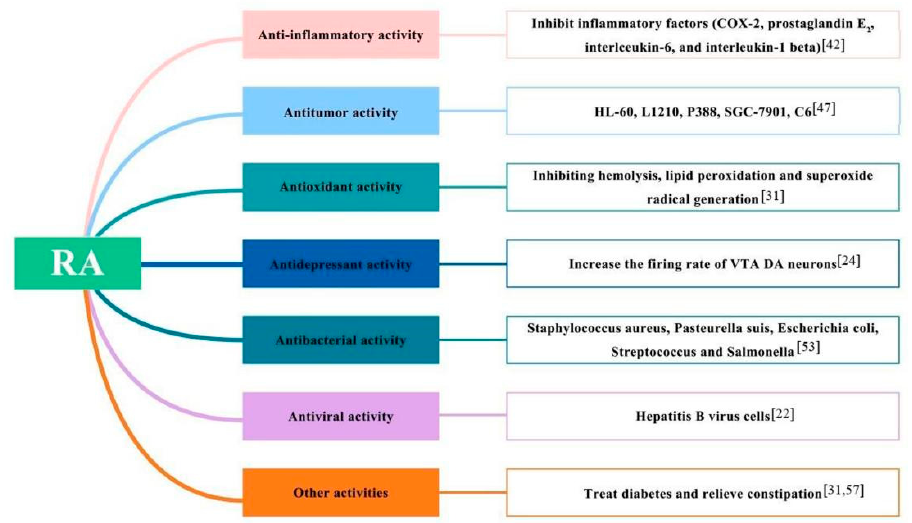
Figure 7. The molecular pharmacological activity mechanisms of Radix Asteri.